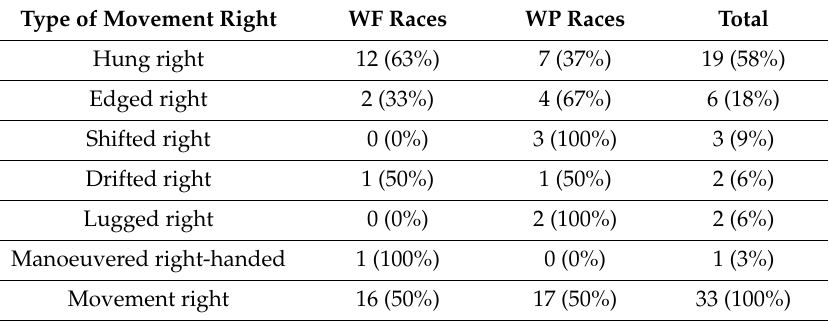
Table 2. The 33 instances of horses moving to the right, as described in the stewards’ reports, (excluding the one instance of a horse moving both